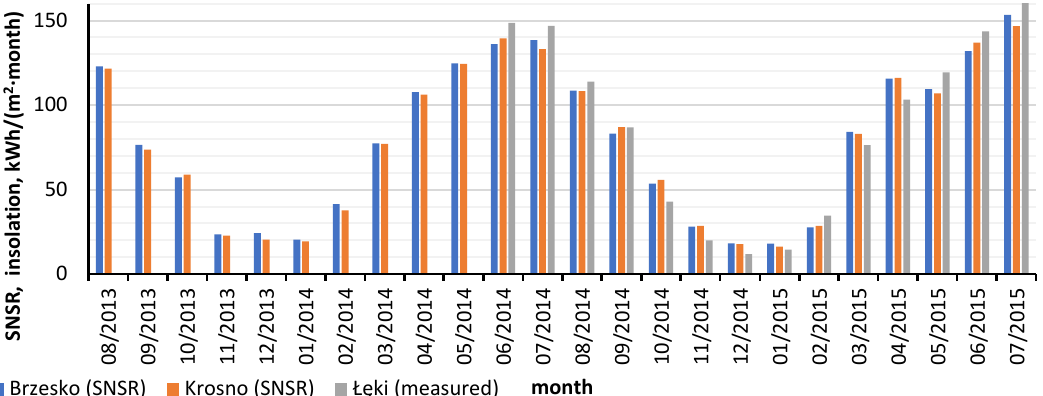
Figure 7. The comparison of monthly surface net solar radiation (SNSR) between Brzesko and Krosno and data from solar radiation measurements (insolation) in Łęki. Source: own study based on References [47,48].